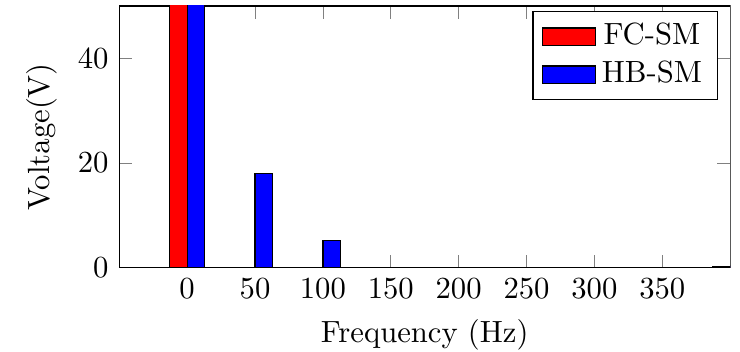
Figure 10. Harmonic spectra of the FC and HB-SM capacitor